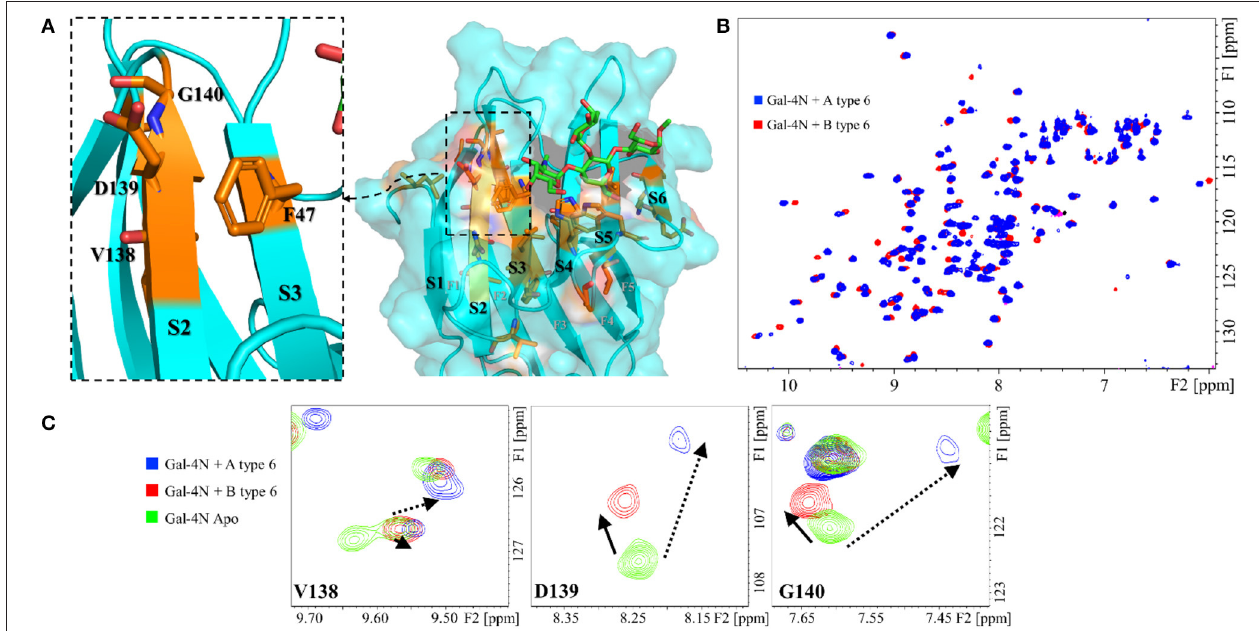
FIGURE 4 | Protein backbone CSP analysis for the interaction of Gal-4N with A and B type-6 tetrasaccharide antigens. (A) Molecular model (MD simulation) for the complex of Gal-4N with A type-6 antigen. The residues that significantly differ in their chemical shift perturbation upon binding to group A or B antigens are highlighted in orange, as well as F47 (unknown resonance assignment). Left: zoom at the S2–S3 region showing residues F46, V138, D139, and G140. (B) Superimposition of the 1 H- 15 N HSQC spectra of Gal-4N in the presence of A type-6 (blue) and B type-6 antigens (red). (C) Expansion of the 1 H- 15 N HSQC spectra at residues V138, D139, and G140: in green, Gal-4N apo; in blue, Gal-4N/A type-6 (12 eq.); and in red Gal-4N/B type-6 (10 eq.).